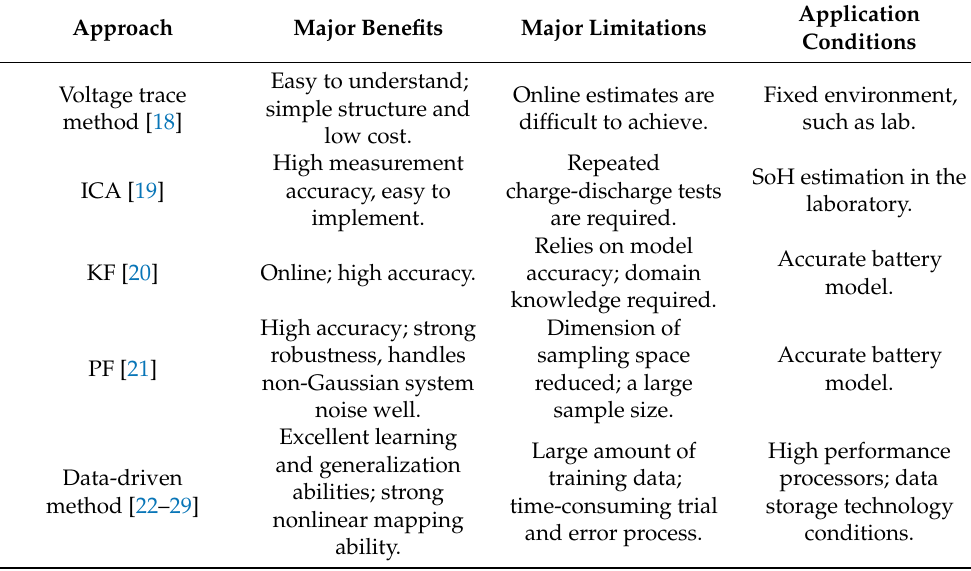
Table 2. Summary of battery SoH estimation